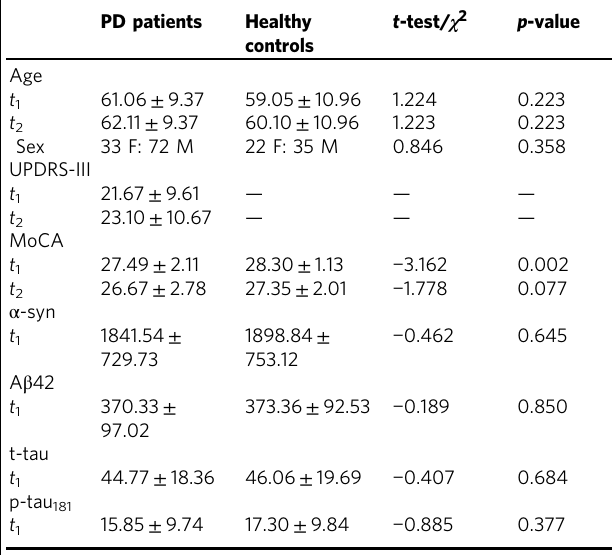
Table 1 Demographic, clinical, and laboratory